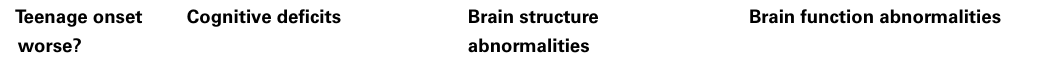
Table 1 | Human studies reporting neurocognitive effects of regular alcohol and marijuana exposure in adolescents and emerging adults (organized by cognitive, structural, or functional consequences and clustered according to functional